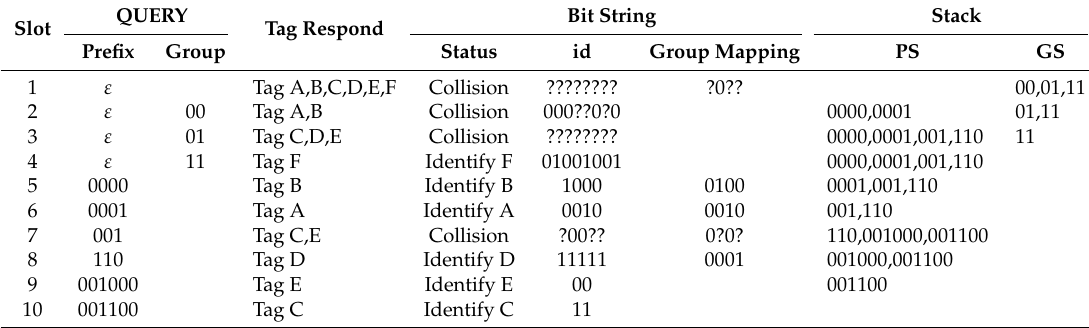
Table 3. The identification procedure of six